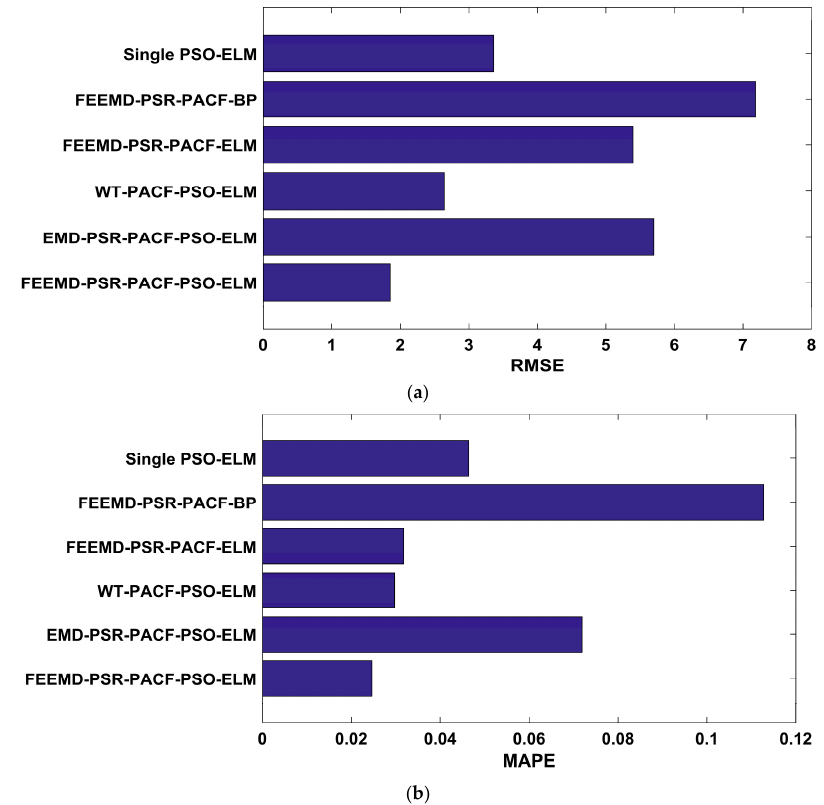
Figure 12. The results of the analysis of the carbon price prediction for Beijing. ( a ) is the root mean square error (RMSE) value; ( b ) is the mean absolute percentage error (MAPE) value.